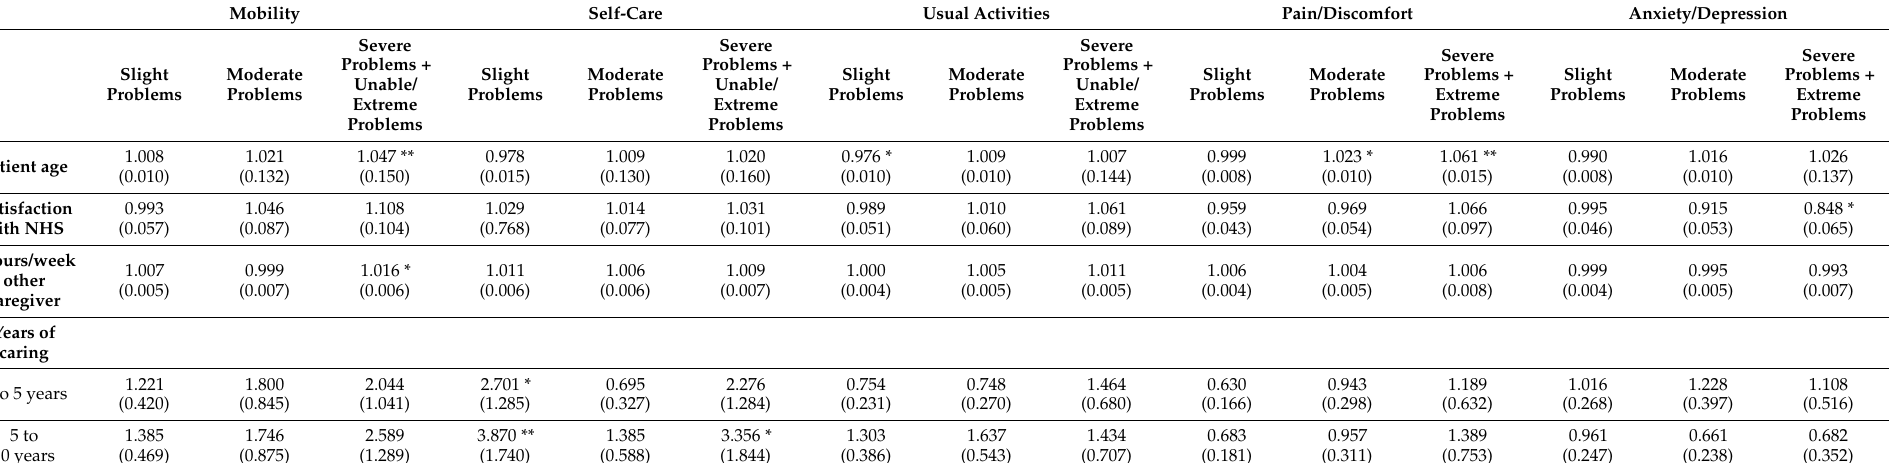
Table 4. Odds ratio (Standard error) Multinomial logit regression model results for each dimension of